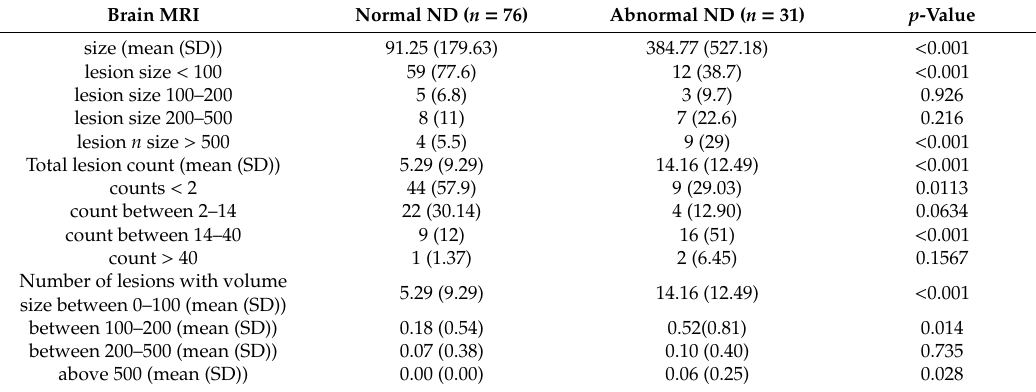
Table 3. Total lesion count and size in the brain MRI in association with neurodevelopmental (ND) outcomes at 18–24